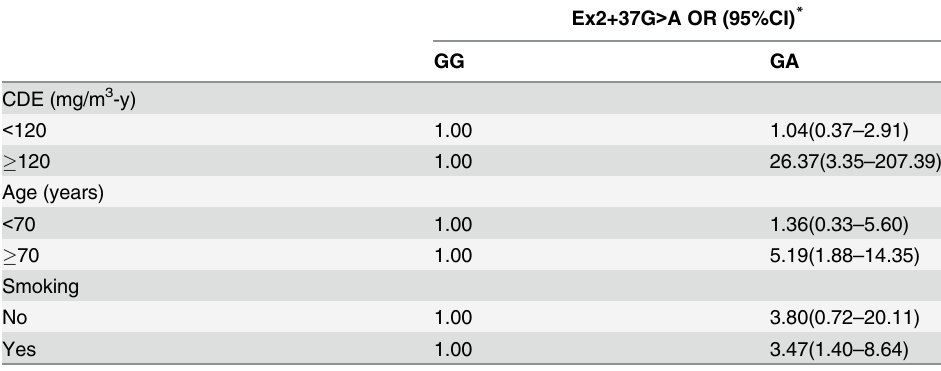
Table 6. Stratification analysis for associations between genotypes of caspase-1 and the risk of